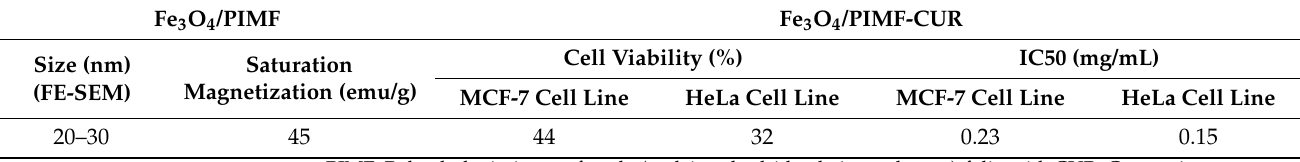
Table 2. Characteristics of nano-carriers based on Fe 3 O 4